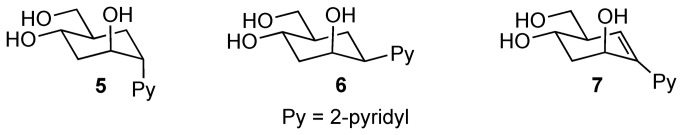
A previously prepared focused library to probe the glycosyl hydrolase enzyme binding pocket.